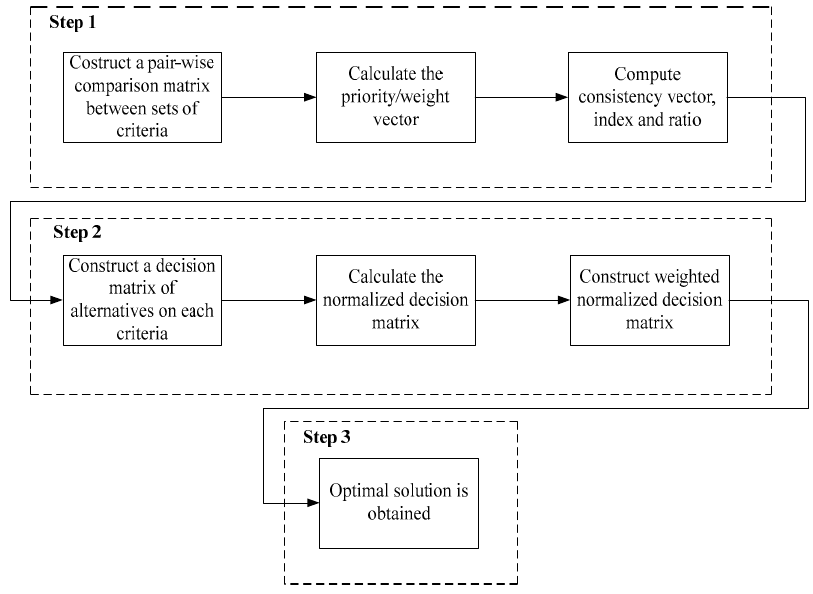
Figure 4. Working process of multicriteria decision and weighted sum methods.